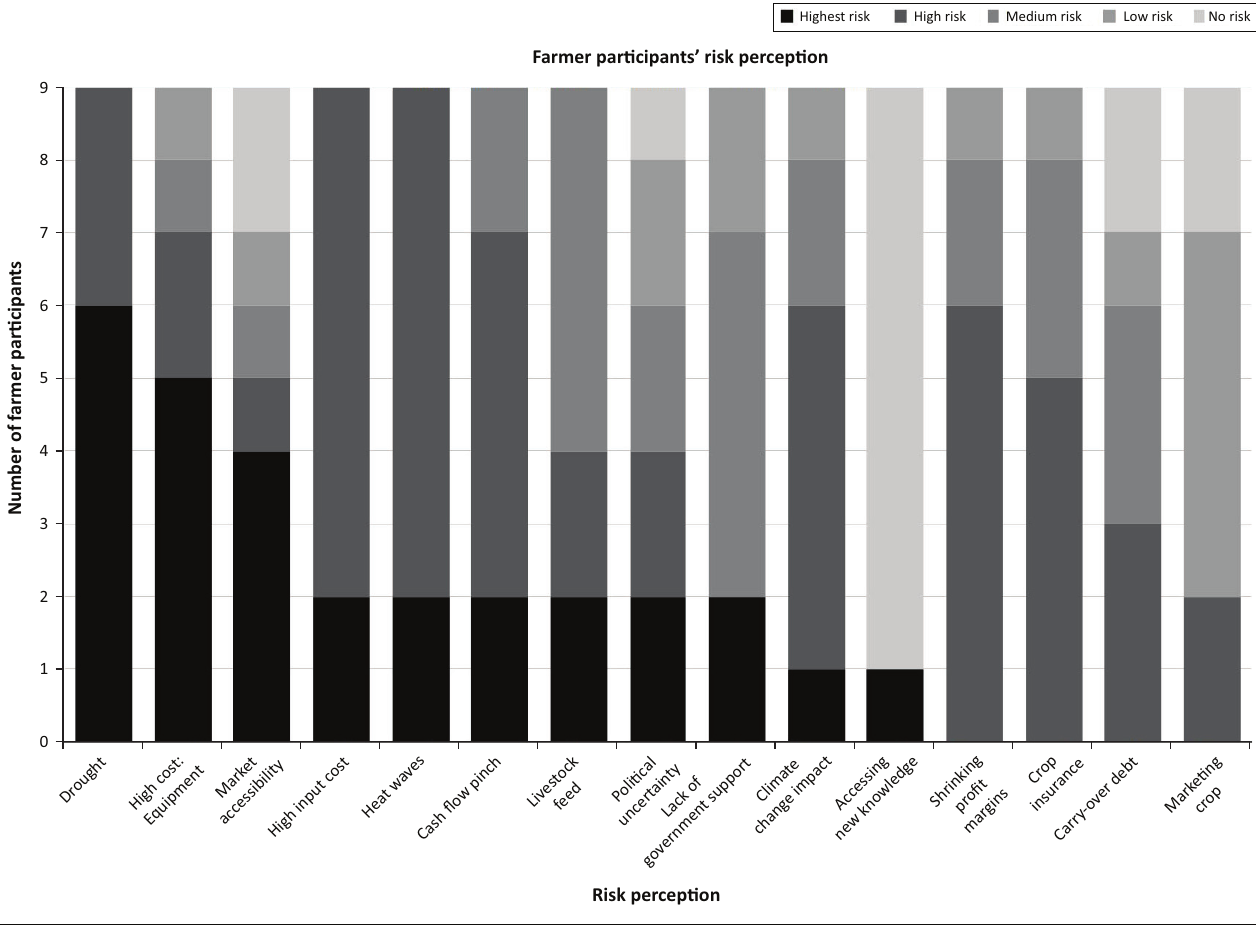
FIGURE 5: Risk Perception Index of farmer